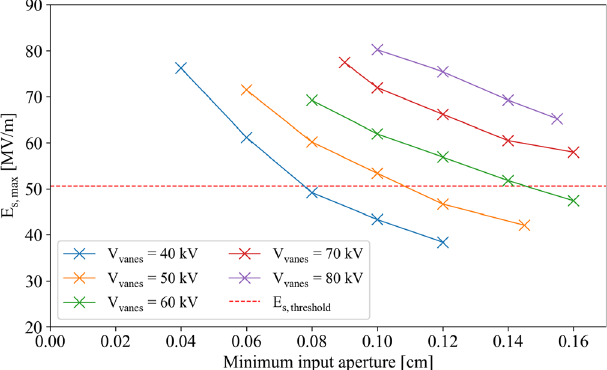
FIG. 2. Maximum surface field as a function of vane voltage and input aperture for different